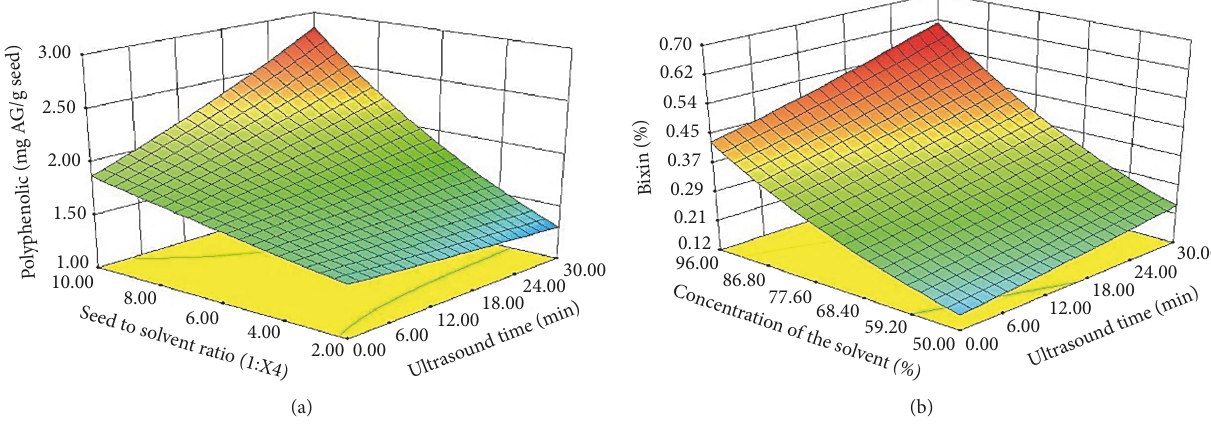
Figure 1: Response surface plots for the significant effects of seed-to-solvent ratio vs. treatment time and concentration of the solvent vs . treatment time for (a) polyphenol compounds and (b) bixin.